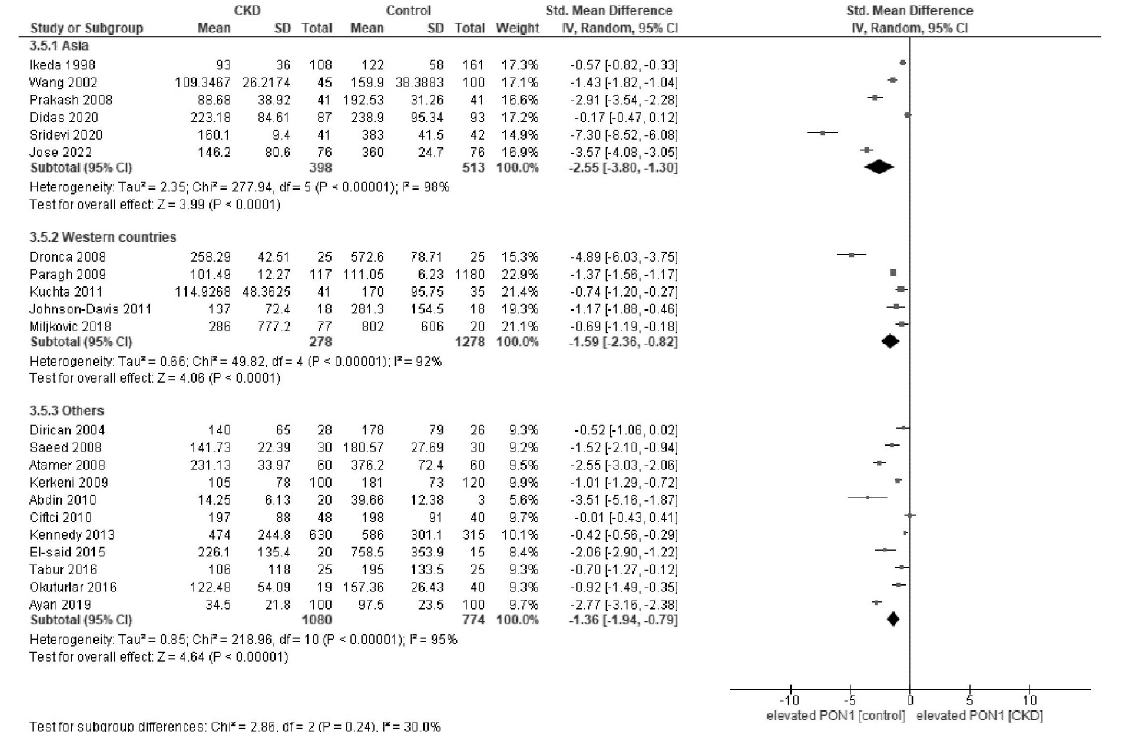
Figure A3. Forest plot of arylesterase activity stratified by diabetes status [28,30,32,34,39,41–43,45– 47].